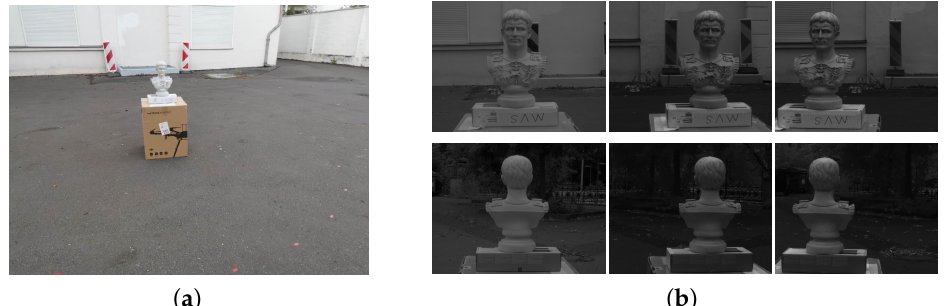
Figure 17. ( a ) is our experiment ground and ( b ) shows sampled triple-image pairs captured from the front (top) and back view (bottom), where from left to right are respectively the color image, the left and the right stereo images. The projected random pattern can be observed from stereo image